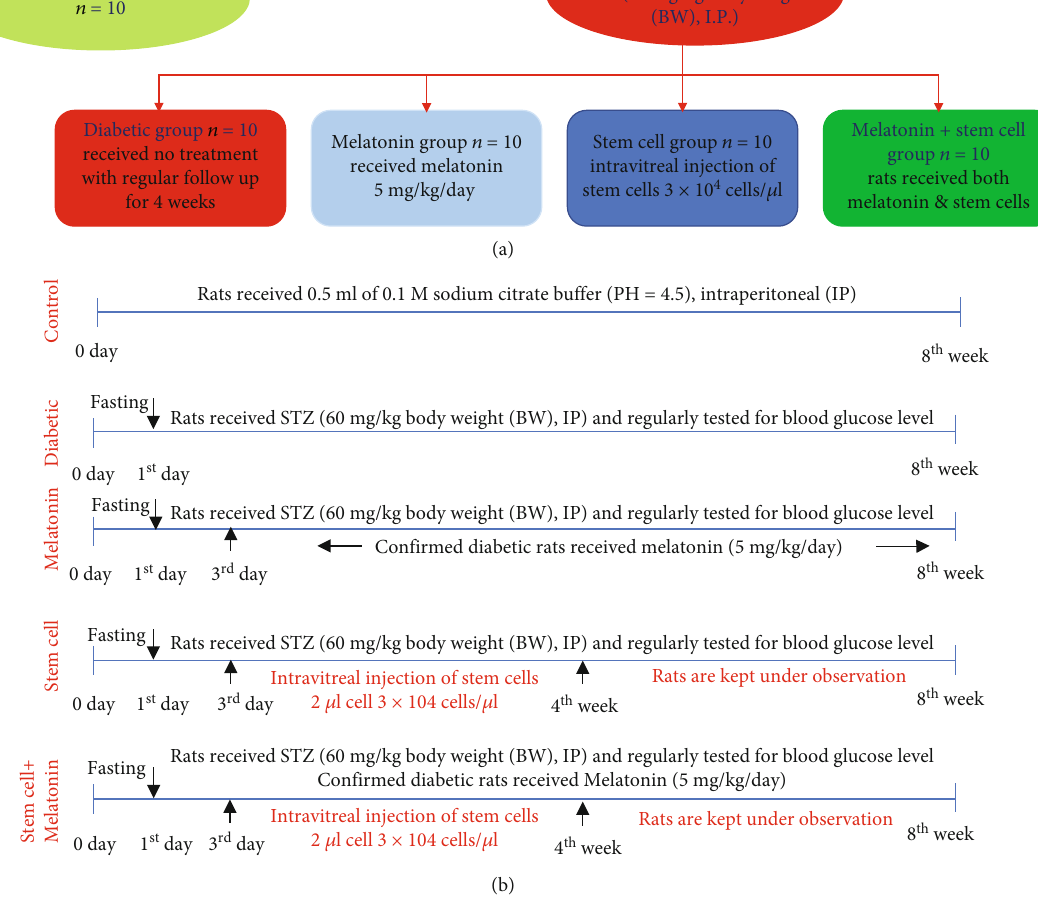
Figure 1: (a) Rat grouping. (b) Experimental design shows the protocol of treatment of each